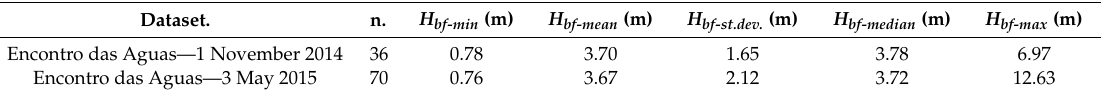
Table 8. Dune height H bf . Legend: H bf-min = minimum wave height; H bf-mean = mean of the wave height; H bf-st.dev. = standard deviation of the wave height; H bf-median = median of the wave height; H bf-max = maximum wave height.